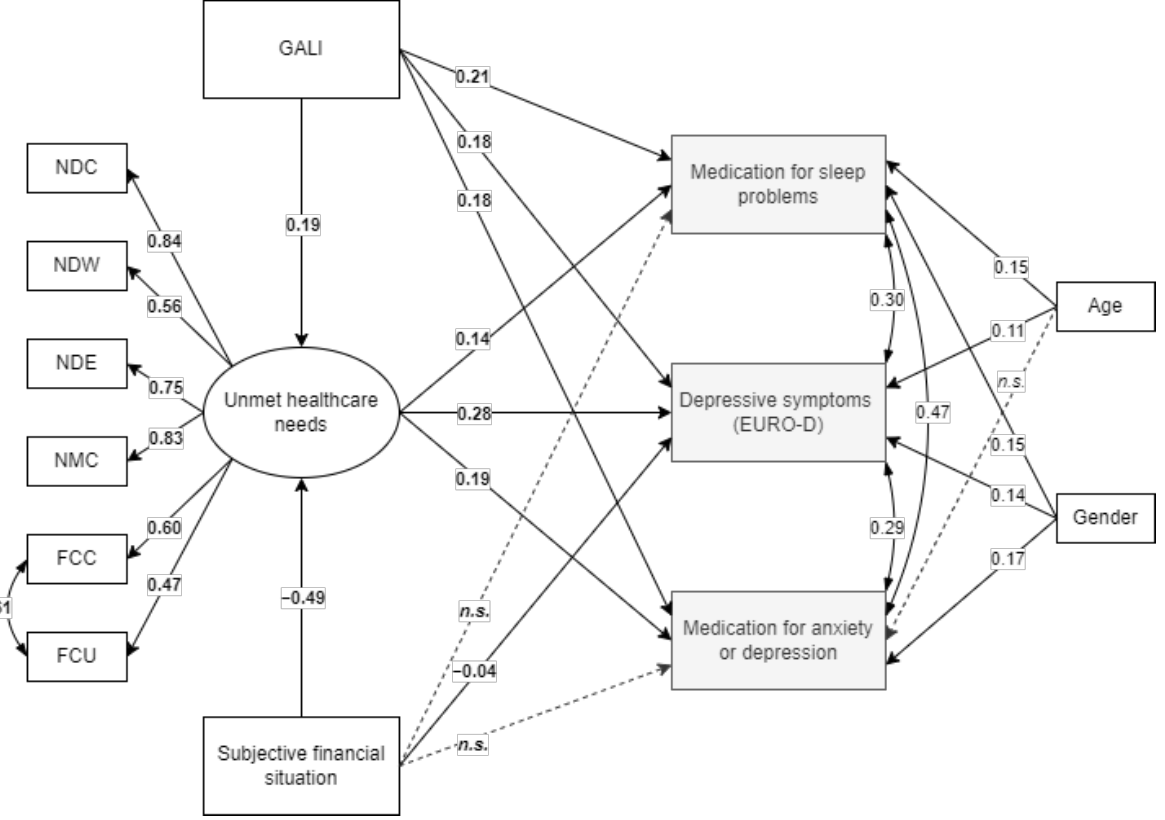
Figure 3. Final Model C results. Note. All estimates presented are significant at level p < 0.001.